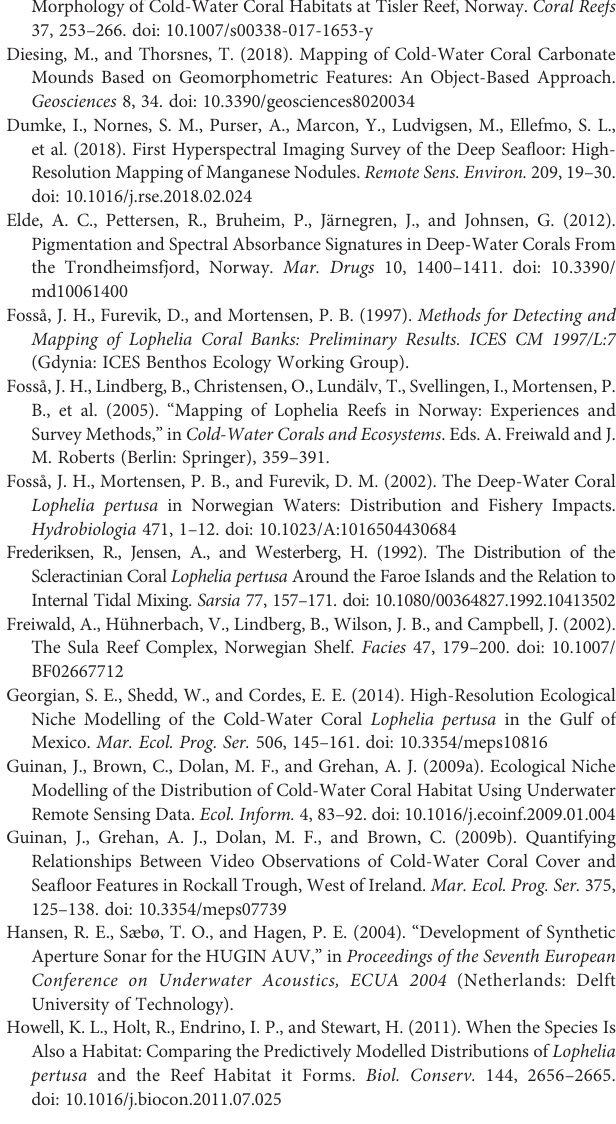
Panels (A-C) showthespectralre fl ectance ( R ( l ))signaturesofwhite Desmophyllum pertusum , orange D. pertusum and the sponge Mycale cf. lingua , respectively ( n = 800 hyperspectral image pixelsper class).Mean R ( l ) signaturesare shownin black. Panel (D) shows all mean R ( l ) signatures plotted together for comparison. Supplementary Figure 3 | Maps of six multibeam echo sounding (MBES)- derived geomorphometric variables covering the majority of the Tautra Ridge (maps based on declassi fi ed bathymetry, courtesy of the Norwegian Mapping Authority). BPI, bathymetric position index. The maps were created in ArcMap (v. 10.8; Esri Inc., Redlands, USA; https://desktop.arcgis.com/en/arcmap/). Projection: UTM 32N. Datum: WGS 1984. Supplementary Figure 4 | Comparison of different mapping techniques. Panels (A,B) showresultsofthesyntheticaperturesonar(SAS)survey.Panels (C,D) show results of the underwater hyperspectral imaging (UHI) survey. Panels (E, F) show results of the multibeam echo sounding (MBES)-based random forest (RF) prediction model. All panels correspond to the same geographic area. The maps were created in ArcMap (v. 10.8; Esri Inc., Redlands, USA; https://desktop.arcgis. com/en/arcmap/). Projection: UTM 32N. Datum: WGS